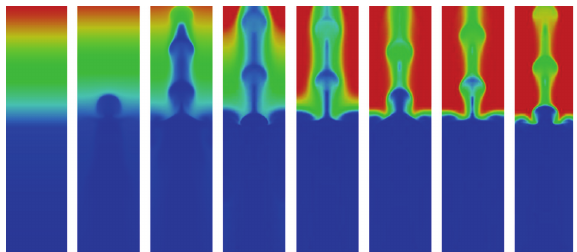
Figure 3: Direct Numerical Simulation of heat transfer induced by a bubble swarm at the metal-oxide